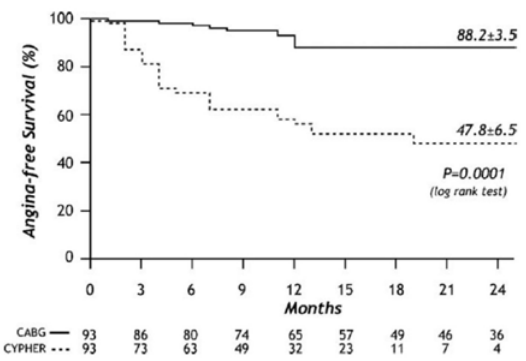
Fig. 5 - Sobrevivência livre de Angina comparando “Stent” Cypher x revascularização cirúrgica do miocárdio - Ben- Gal et al., 2006 [4]